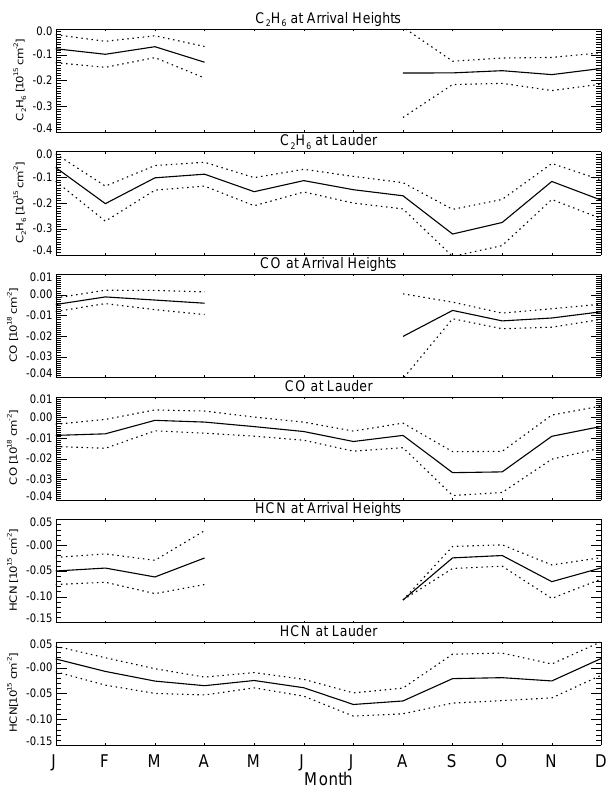
Fig. 2. Month-by-month trends (moleculescm − 2 yr − 1 ) with asso- ciated 95% confidence